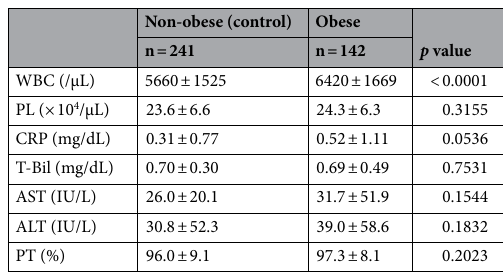
Table 2. Preoperative laboratory data. WBC, white blood cell; PL, platelet; CRP, C-reactive protein; T-Bil, total bilirubin; AST, aspartate aminotransferase; ALT, alanine aminotransferase; PT, prothrombin time.